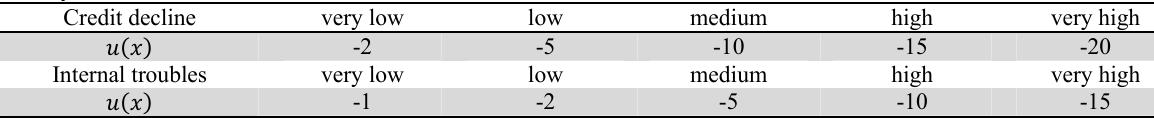
Utility of the results of